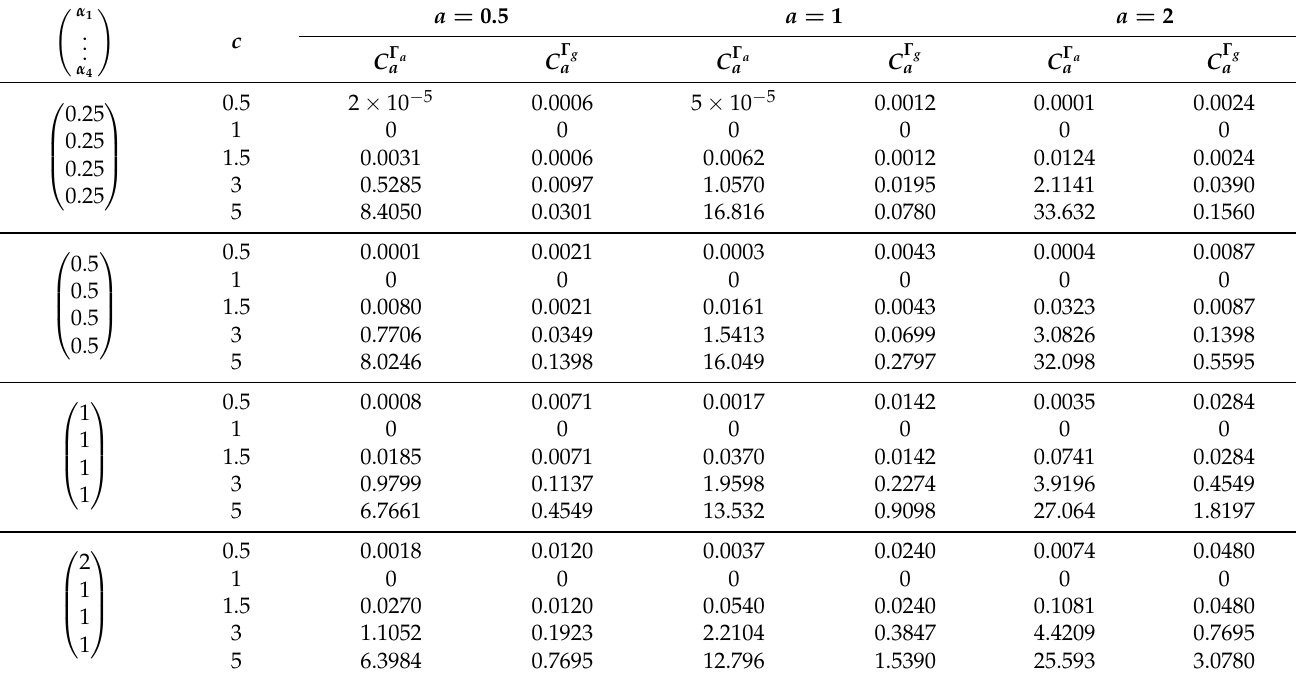
Table 5. Values of the local curvature for two classes Γ a and Γ g for a sample generated from Mn(20,(1/4,1/4,1/4,1/4)). (cid:32) α 1